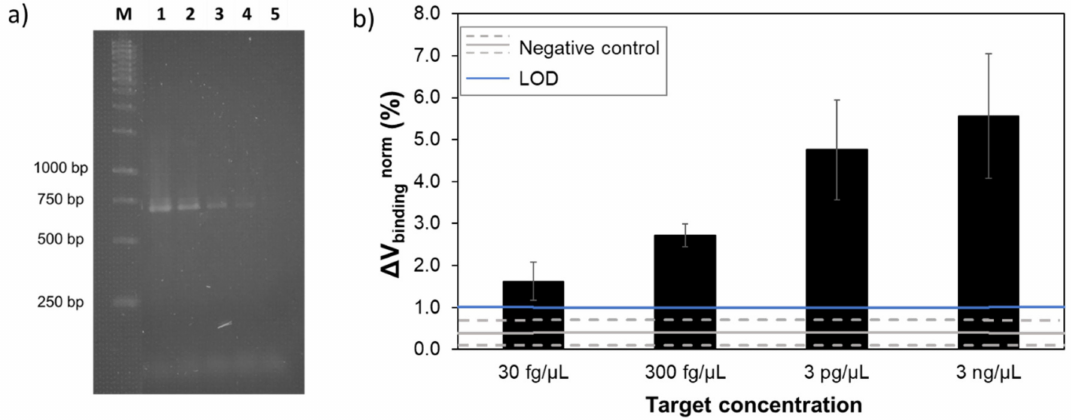
Figure 4. ( a ) 1.5% agarose gel electrophoresis of asymmetric PCR amplicons obtained from template DNA of S. agalactiae at di ff erent concentrations in the reaction mixture. Lane M: 1 kb DNA ladder; lane 1–4: 3 pg / µ L, 300 fg / µ L, 30 fg / µ L and 3 fg / µ L of S. agalactiae template DNA, respectively; lane 5: negative control (no template DNA). ( b ) Normalized binding signals obtained from the detection of